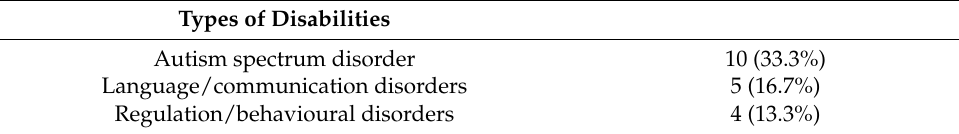
Table 3. Summary of disabilities of the DD